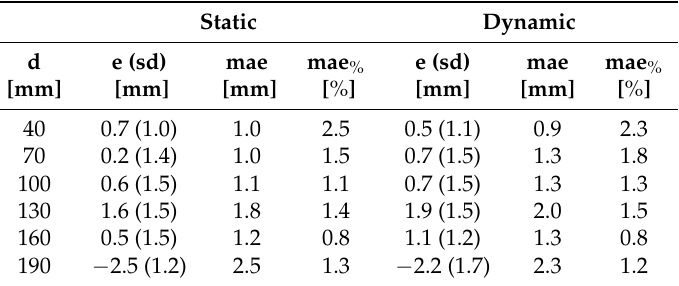
Table 2. Mean error with standard deviation (e (sd)), mean absolute error (mae) and mean absolute percentage error (mae % ) for AoI = 0 ◦ during both static and dynamic acquisitions using a white rectangular cuboid target.